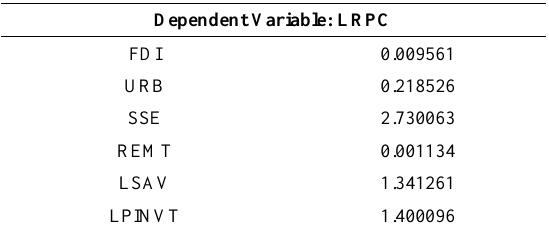
Table 3. Normalized Cointegrating Coefficients